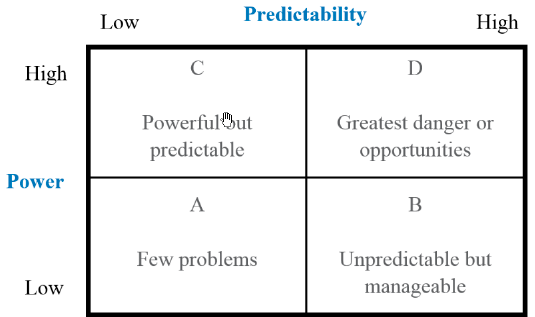
Figure 4. Power-Dynamics Matrix (adapted from Mendelow [31]).